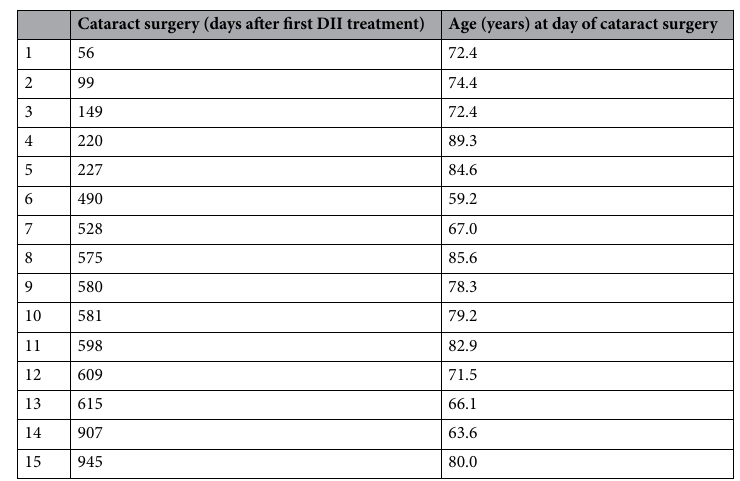
Table 1. Cataract surgery. In total, 15 of 58 eyes that were phakic at the time of first injection received cataract surgery within the first 3 years after their first DII injection. The table shows the temporal distribution of cataract surgery and age of the patient at surgery. Cataract surgery was most frequently performed in the first and second year after DII injection. Mean age of patients at cataract surgery was 75.1 (range 59–89). Mean BCVA before cataract surgery was 44.7 ± 21.1 letters. Mean IOP on the last visit before cataract surgery was 18.5 ± 5.6 mmHg.